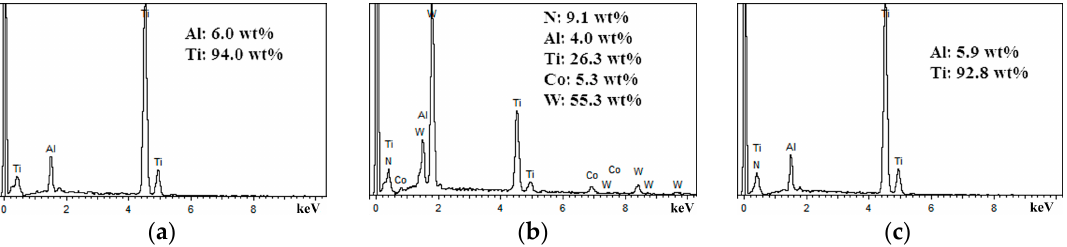
Figure 5. Analysis of chemical composition for points selected in Figure 4b: ( a ) point A; ( b ) point B; and ( c ) point C.